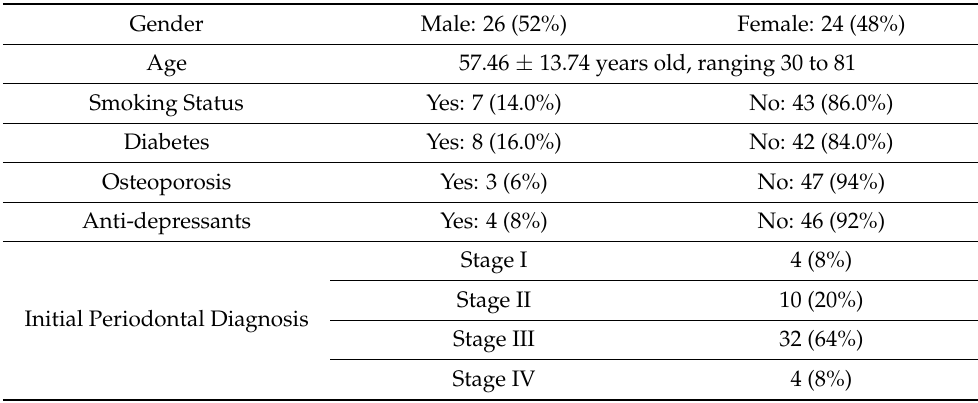
Table 1. Demographic data of the